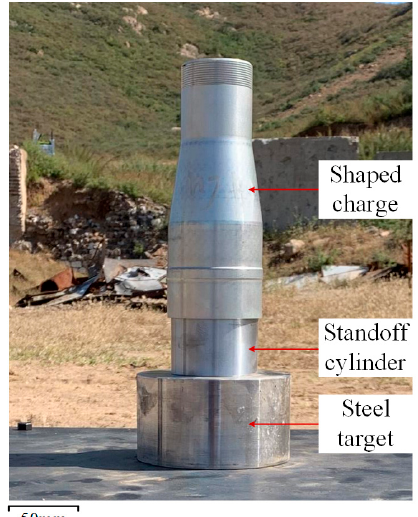
Figure 4. Experimental setup of the SC against steel